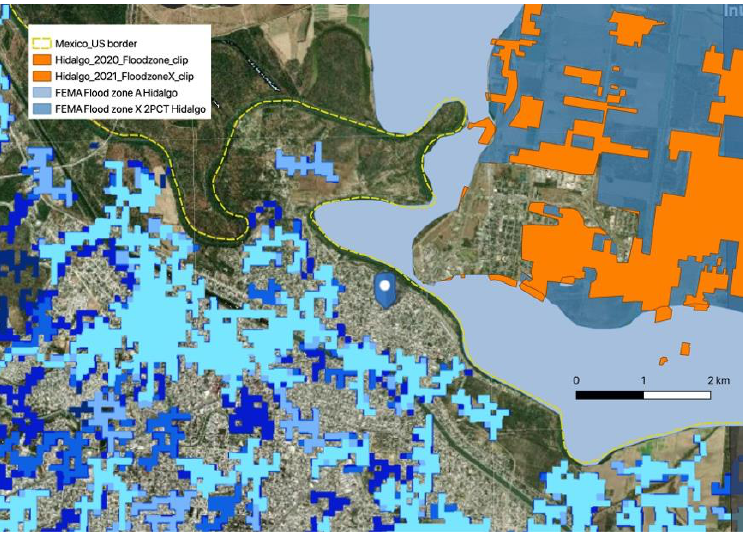
Figure 6. Hidalgo urban area (orange) exposed to floods in 2020. Note that flood hazard mapping styles and methods differ between Mexico (Atlas Gob) and the USA (FEMA). See Table A2 for data sources.